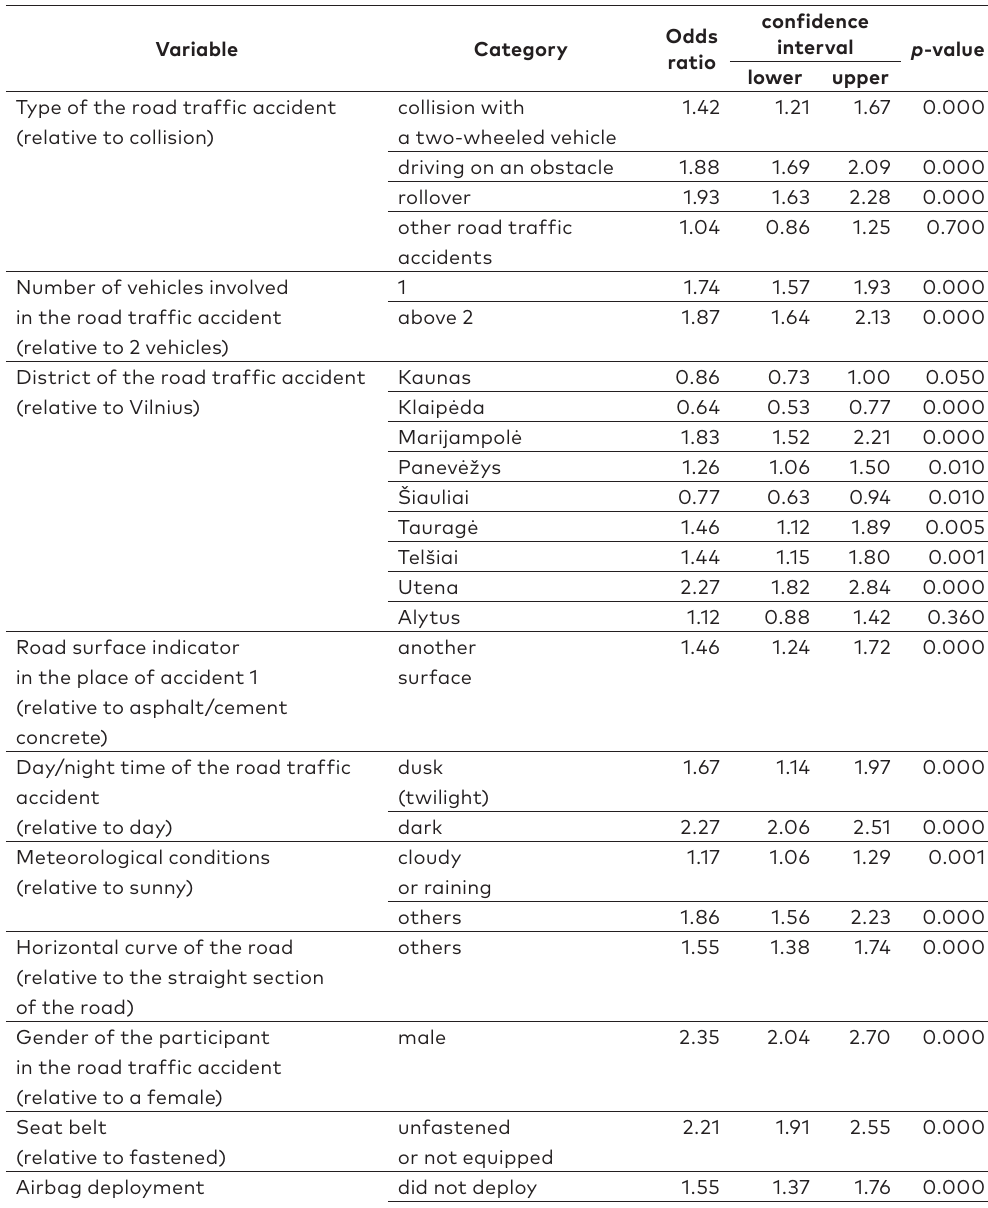
Table 4. The effects of the identified factors on the